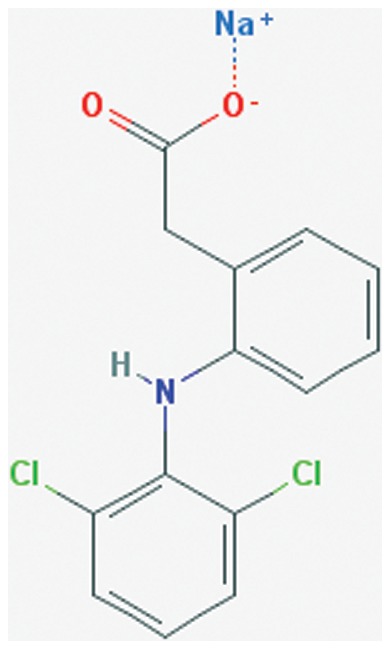
Chemical structure of diclofenac sodium [46].